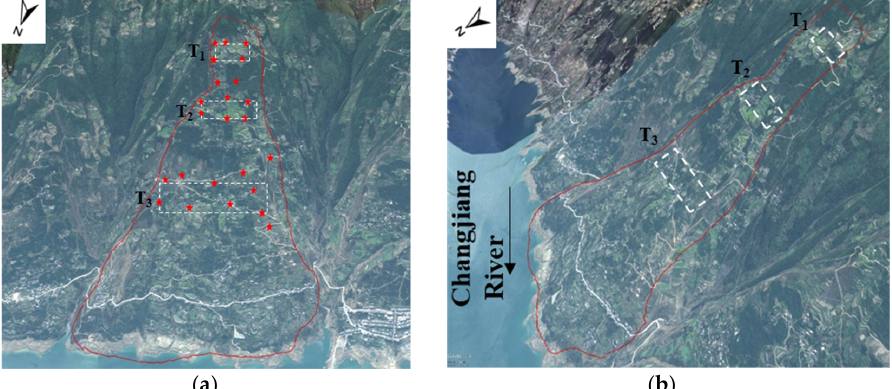
Figure 10. Geomorphological features of the Xinpu landslide showing ( a ) front view and ( b ) lateral view (the measuring points are marked with red